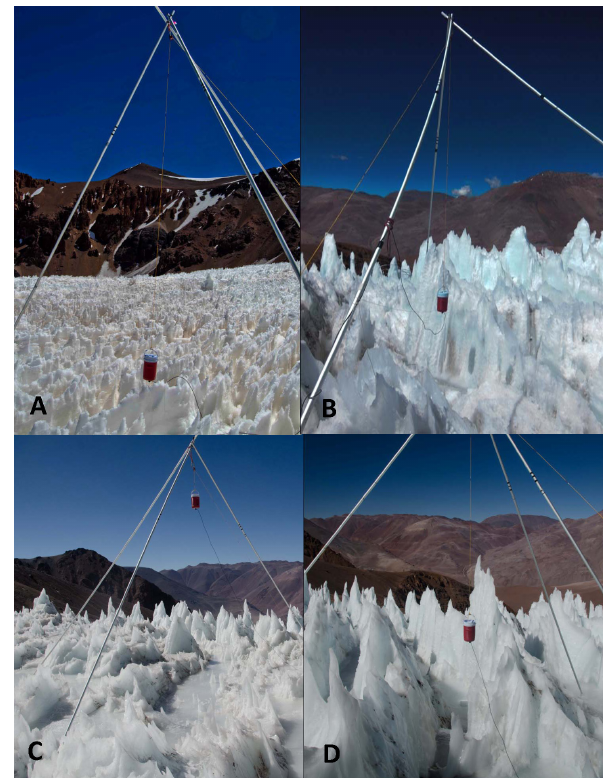
Figure 1. Glaciar Tapado with the location of the AWS where albedo experiments were carried out. The inset shows the location in South America close to the Chilean–Argentinean border.